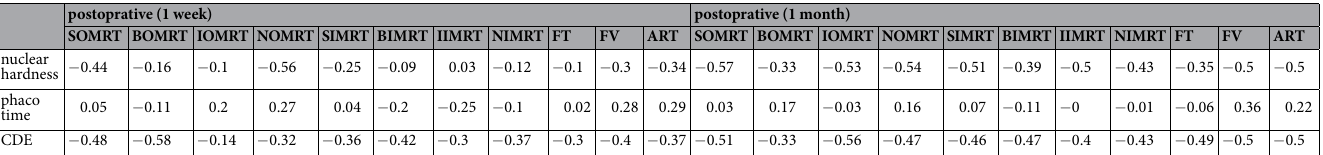
Table 4. The Correlation between Nuclear Hardness, Phaco Time, CDE and Macular thickness after Operation (ARC Group). SOMRT = superior outer macular ring thickness; BOMRT = bitamporal outer macular ring thickness; IOMRT = inferior outer macular ring thickness; NOMRT = nasal outer macular ring thickness; SIMRT = superior inter macular ring thickness; BIMRT = bitamporal inter macular ring thickness; IIMRT = inferior inter macular ring thickness; NIMRT = nasal inter macular ring thickness; FT = foveal thickness; FV = foveal volume; ART = average retinal thickness; CDE = cumulative dissipated